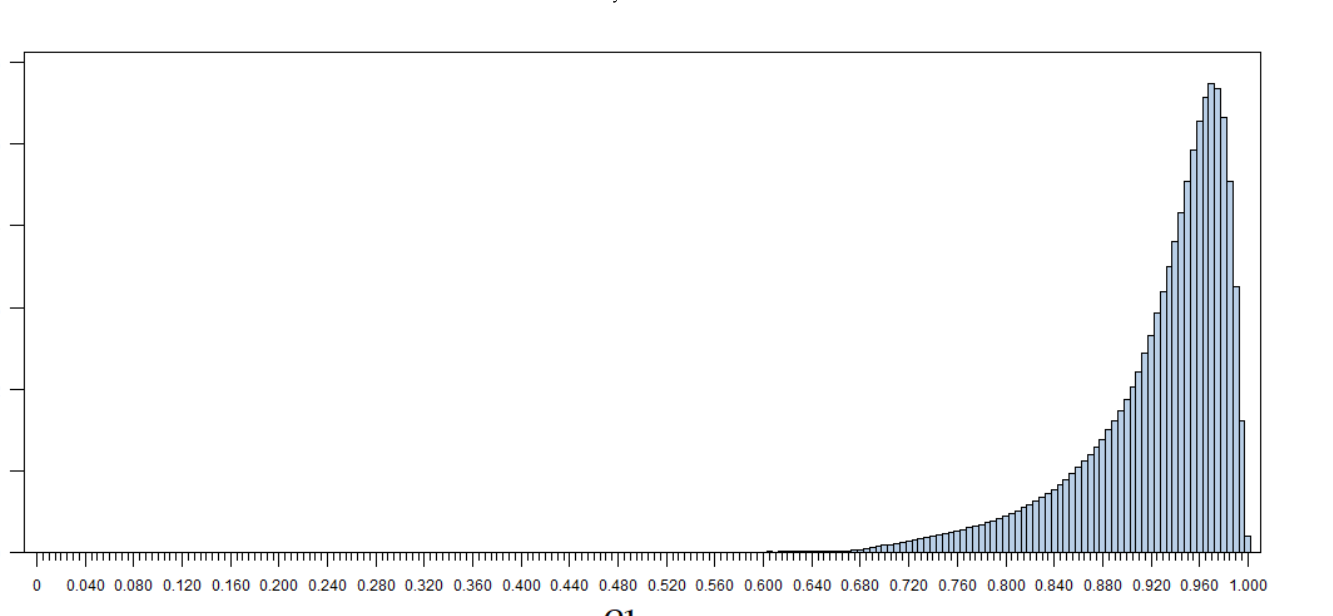
Figure 10. Distribution of the quality measure Q 1 (standardized version of SV ), of the mesh of the real model of the bouton. Probability (percent) − vertical